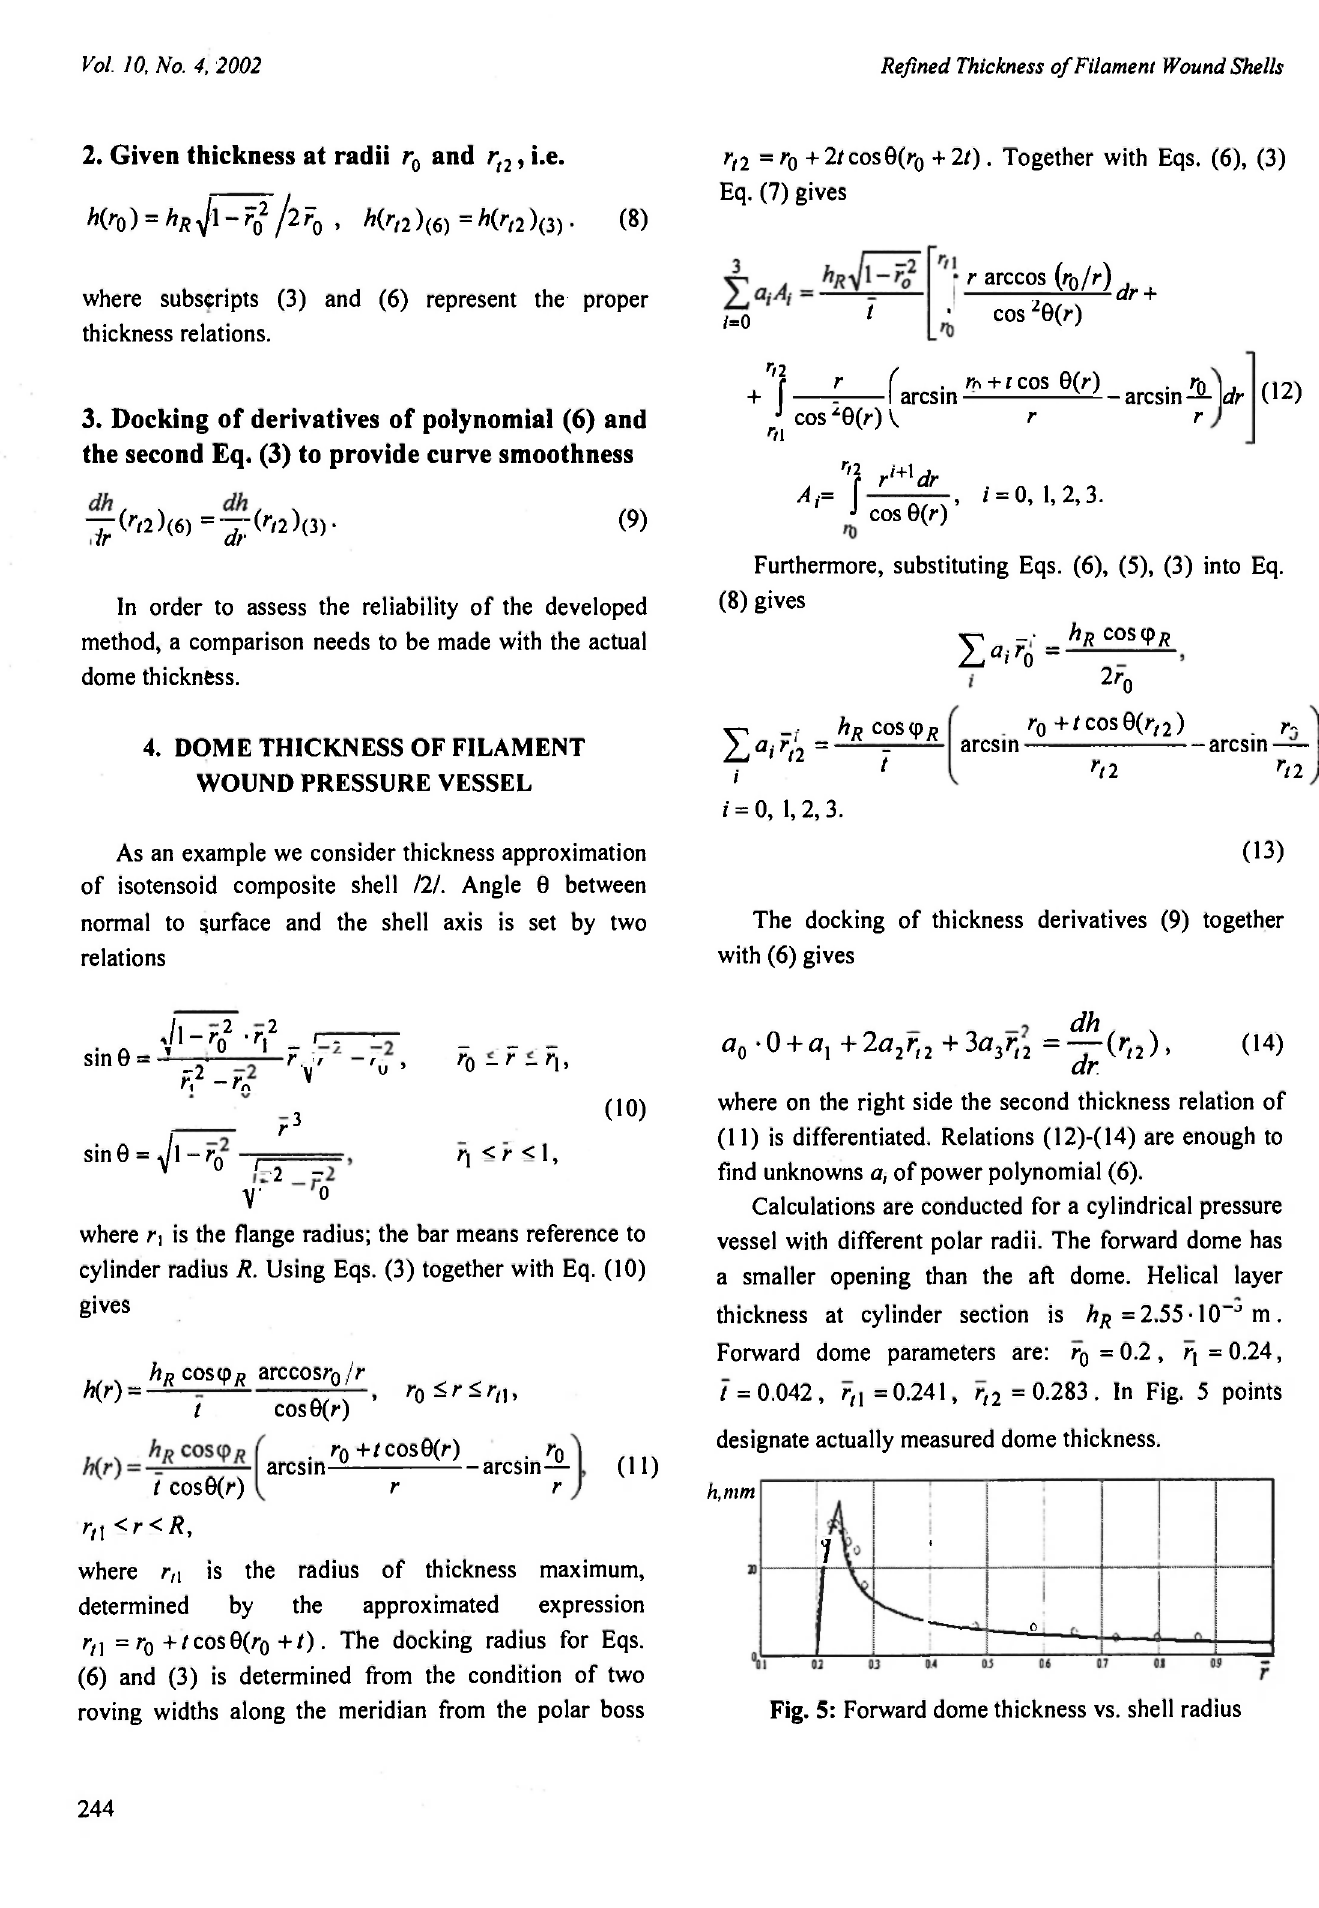
Fig. 5: Forward dome thickness vs. shell